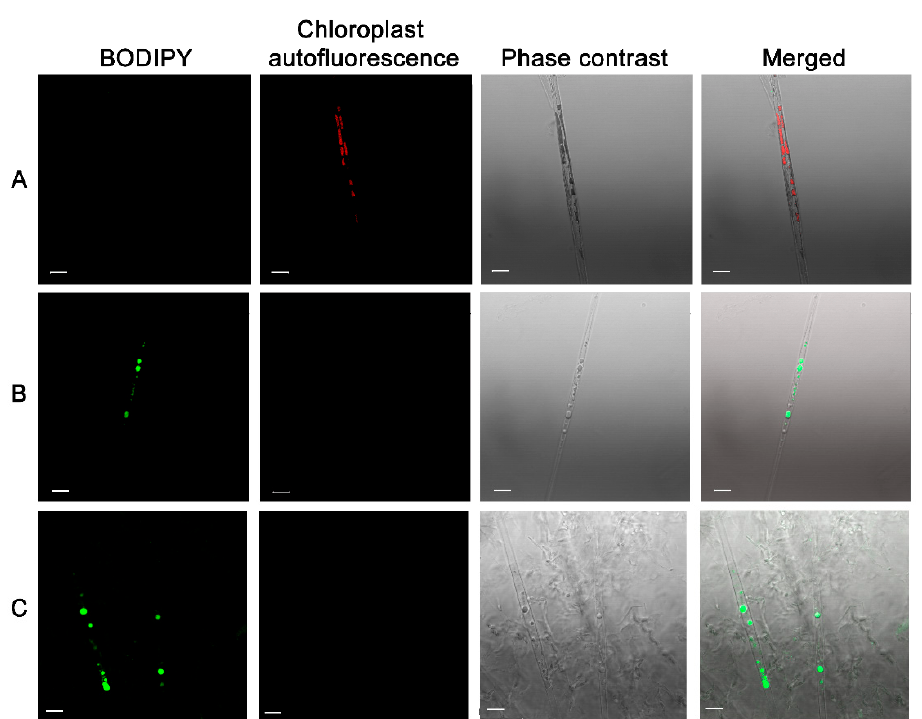
Figure 9. Induction of lipids accumulation after culturing with bacterial culture B. mycoides BS2-15 and bacterial filtrate for 7 days. The cells were stained with BODIPY and observed with a confocal microscope. ( A ) axenic culture; ( B ) culture with added bacterial filtrate; ( C ) culture with added B. mycoides BS2-15 bacterial culture. The red marks autofluorescence of chloroplasts, dye BODIPY fluorescence with green. Scale bar: 10 μ m.